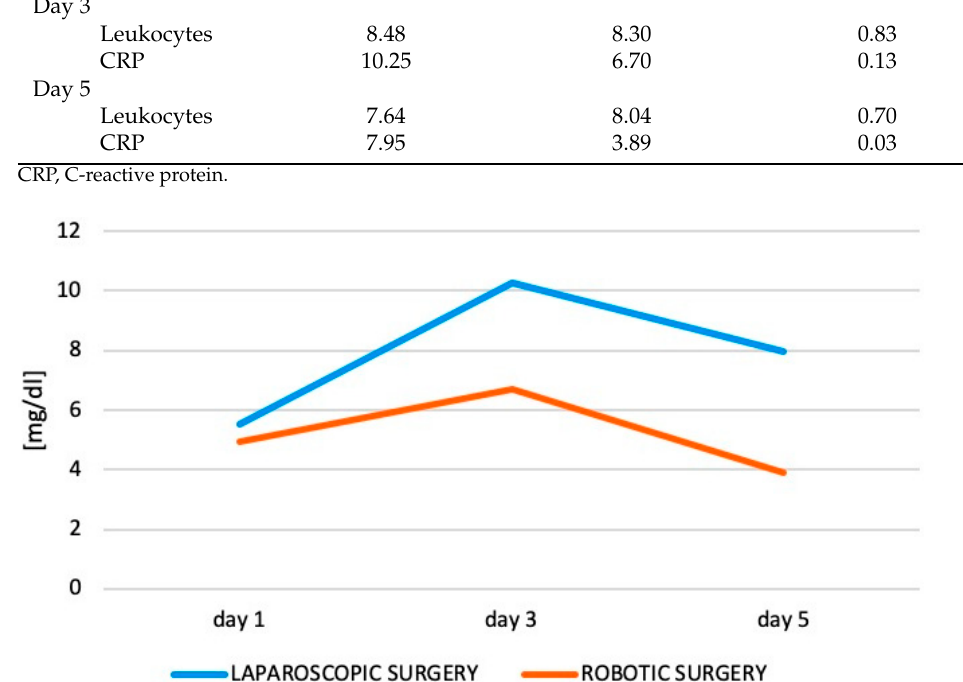
Figure 1. Differences in C-reactive protein (CRP) over time. Table 4. Multivariate analysis for length of hospital stay (LOS).